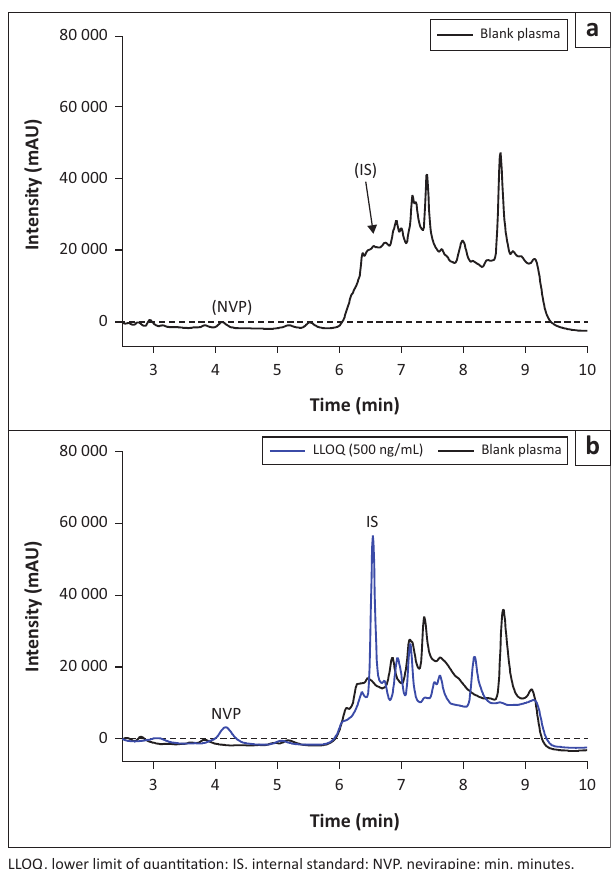
FIGURE 2: Representative nevirapine calibration curve for inter-day precision and accuracy.